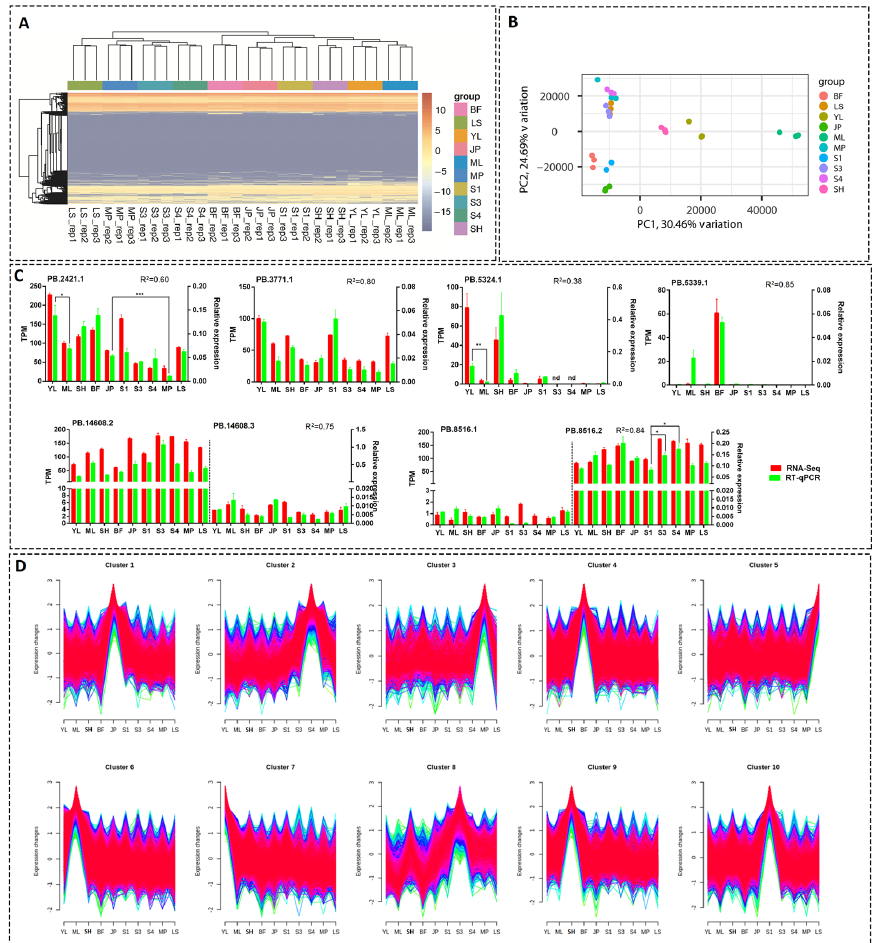
Figure 5. Overall view of transcript expression of each sample. ( A ) Heatmap analysis of all transcripts. ( B ) PCA of gene expression levels of each sample. ( C ) Expression profiles of randomly selected novel and alternative transcripts by RT–qPCR and RNA-Seq. Error bars represent the SE of three biological replicates. R, the Pearson correlation coefficient. *, ** and *** stand for “ p < 0.05”, “ p < 0.01”, and “ p < 0.001” (Student’s t -test), respectively. ( D ) Mfuzz clusters of genes showing variable expression among samples. The colors reflect “Membership” values calculated by Mfuzz software, where red color corresponds to high membership scores and green or blue colors to low values.